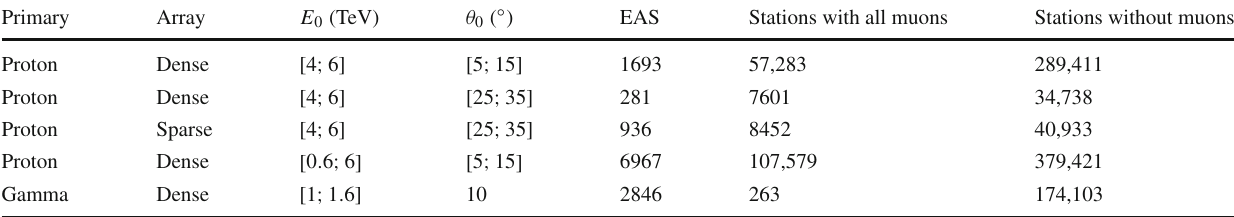
Table 2 Description of the test data